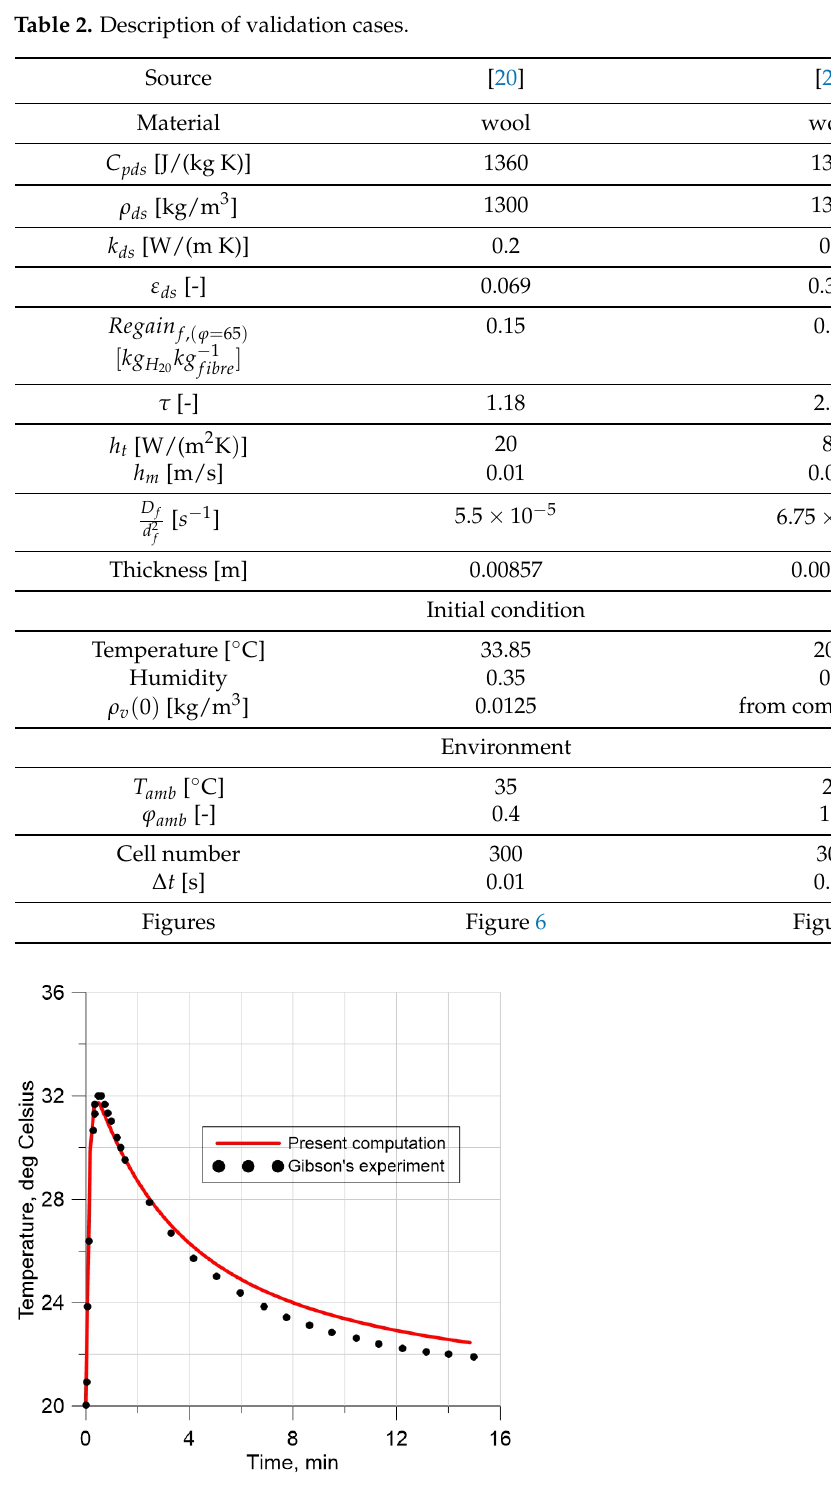
Figure 7. Simulation of the temperature and comparison with measurements